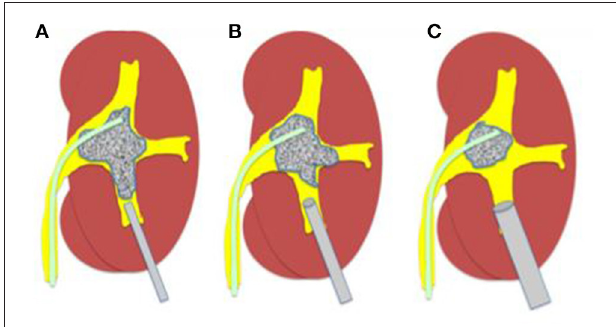
FIGURE 5 | (A) The micro and micro-mini needles with a J-tip super-stiff wire. (B) Fluoroscopic image showing the J-tip wire beyond the stone, securing access. (C) The super stiff wire remains in line with the puncture and perpendicular to the patient making dilatation and upsizing easy. (D) A larger calibre sheath is used here to upsize the tract, while the 4.5 Fr micro needle remains as a “nephroscope” for effective lithotripsy.